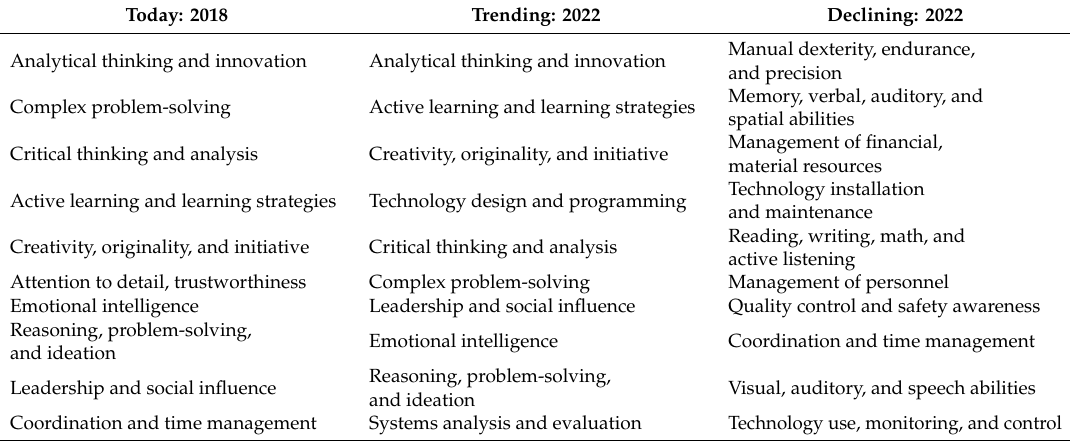
Table 1. Skills demand across sectors: 2018 vs.